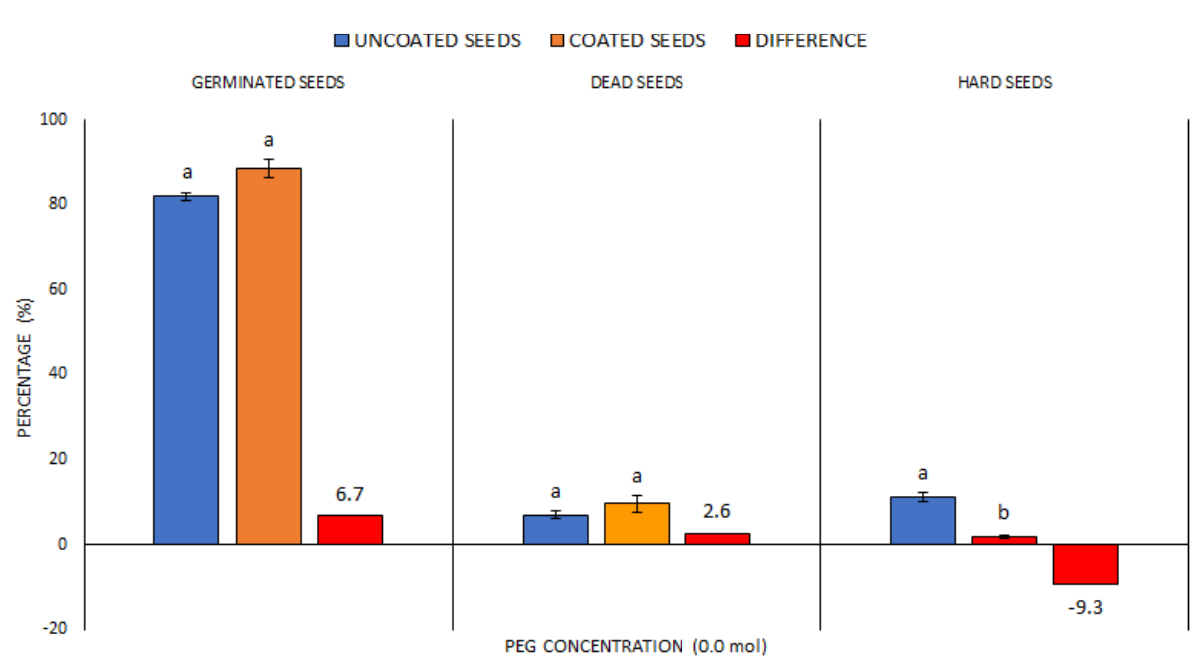
Figure 1. The comparison of germinated, dead and hard seed percentages at control treatment—without drought simulation. Average values for all indicator plants for the US (uncoated seeds; n = 160 ± SE; average of all plant species) and CS (coated seeds; n = 160 ± SE; average of all plant species) treatments with the polyethylenglycol (PEG) concentration = 0.0 mol; different lowercase letters indicate significant difference (ANOVA post-hoc Tukey’s HSD test; p < 0.05) for the respective parameters between the US and CS groups.